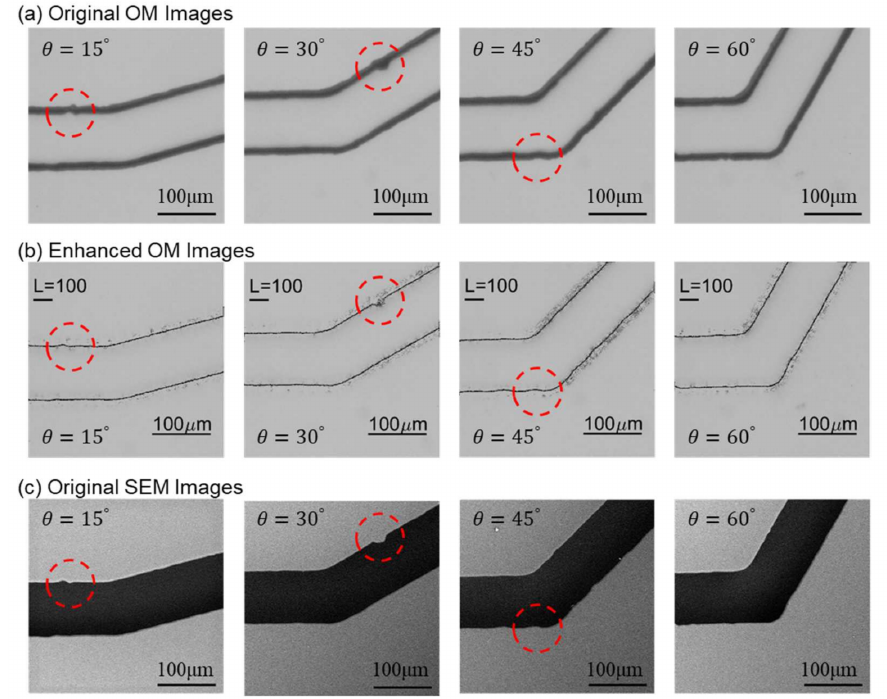
Figure 13. Comparison between original OM, enhanced OM, and SEM